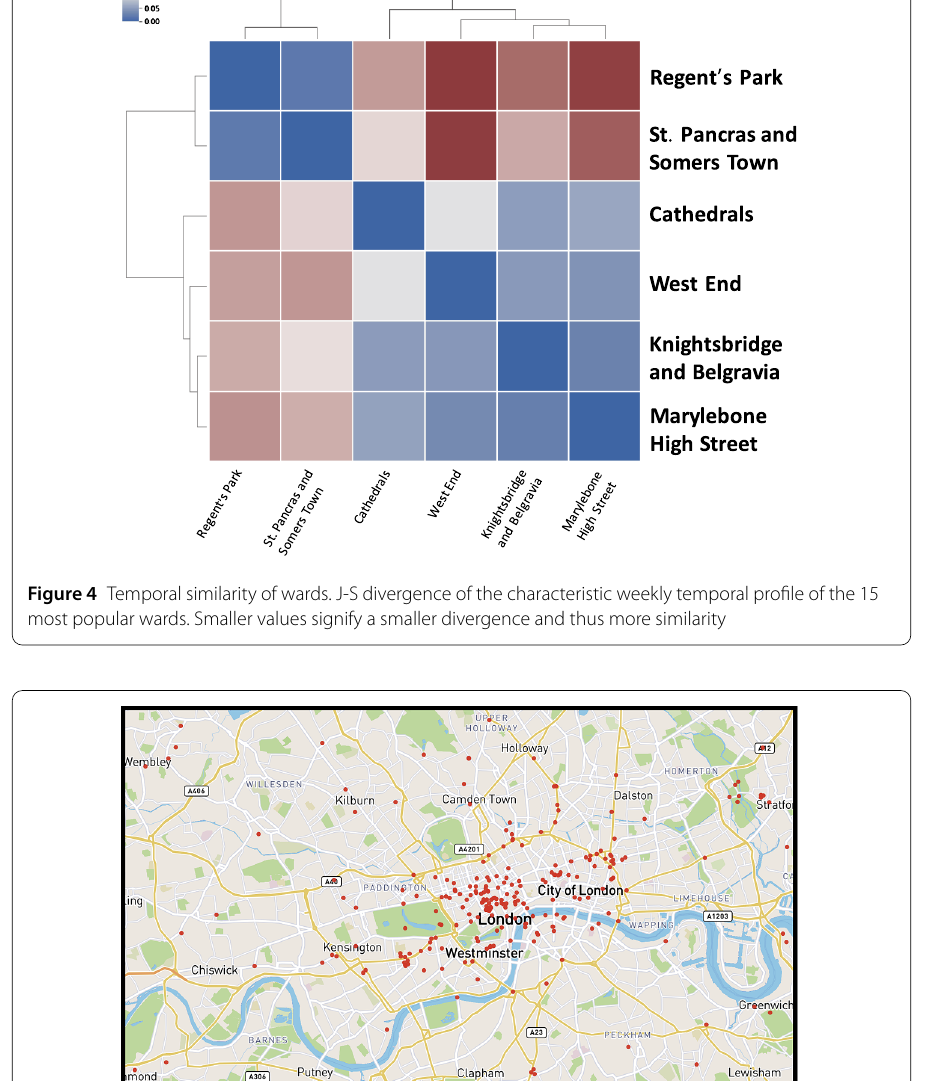
June 2011 were highly likely (probability above 0.8) to actually be new venues opening in an area rather than existing venues being added to the system for the first time [17]. We look at all new venues that were added to Foursquare after June 2011 that had at least 100 check-ins. This results in a list of 305 venues which is used for the following analysis. Within this list of newly opened venues, 32% of the venues fall within the general category of Food , 32% under Travel & Transport , and 8% under Nightlife Spots . These venues were scattered around the city, with their focal point being in center of the city as depicted in Fig.